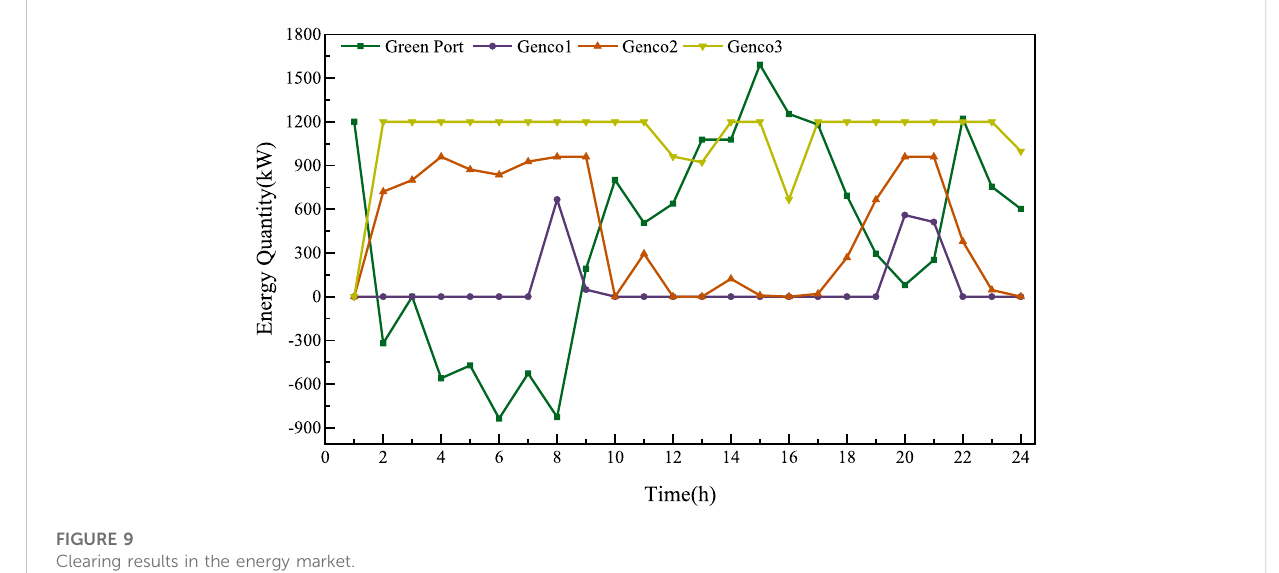
FIGURE 9 Clearing results in the energy market.